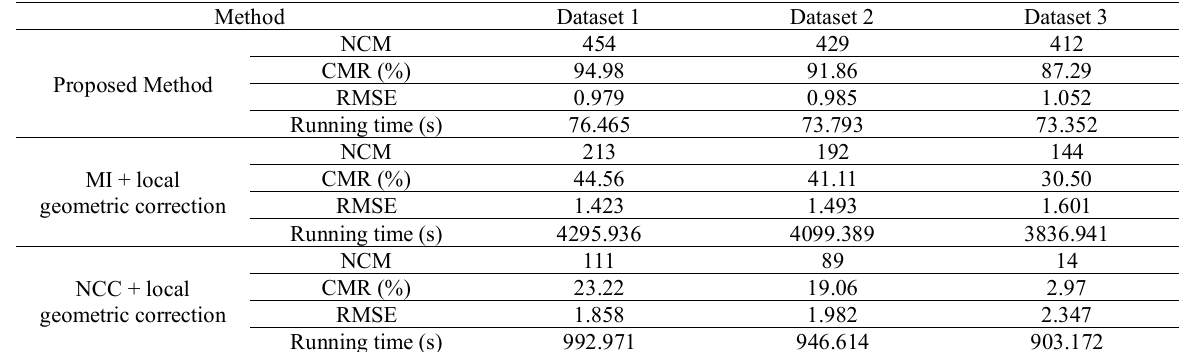
Table 2. Comparison of the proposed method with the MI and NCC methods